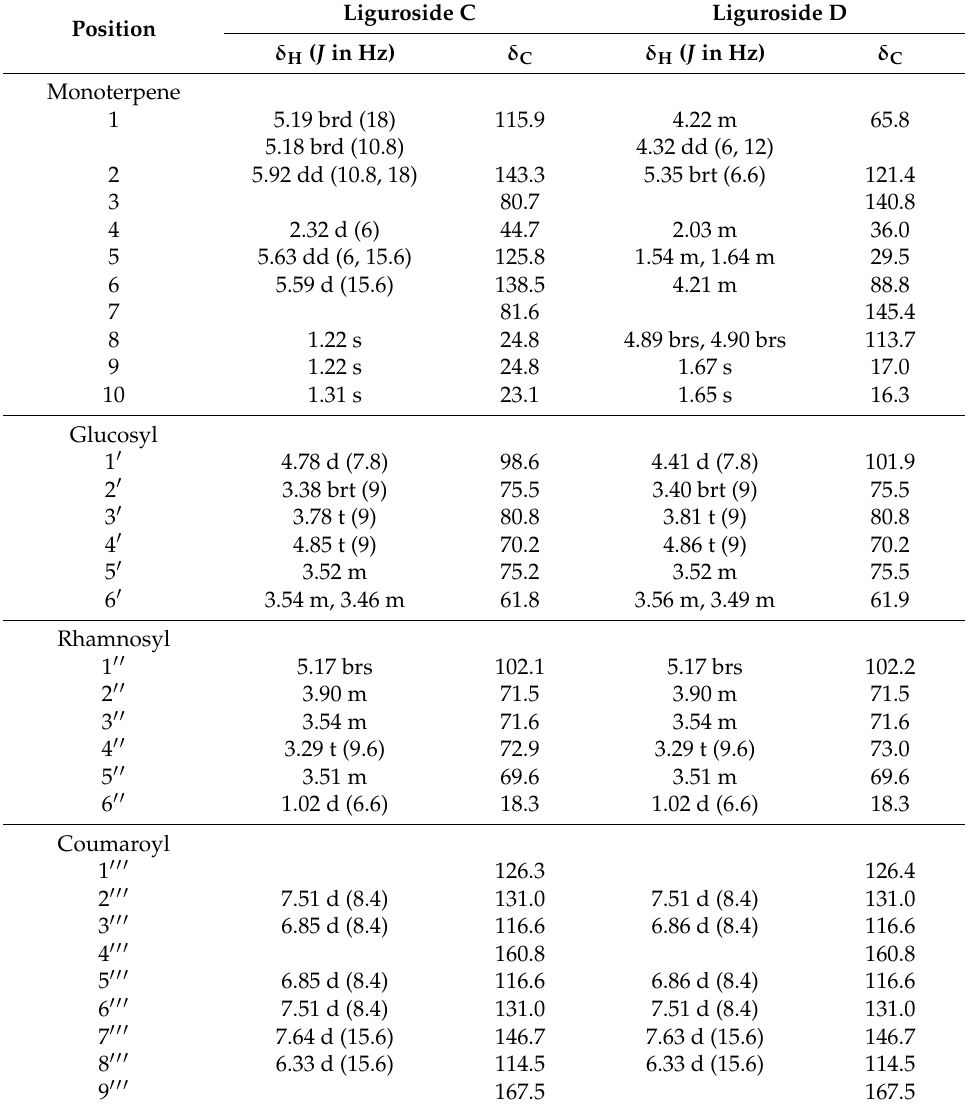
Table 1. 1 H- and 13 C-NMR data of ligurosides C and D in acetone- d 6 -D 2 O (9:1, v / v ) ( δ H : 600 MHz; δ C : 151 MHz).